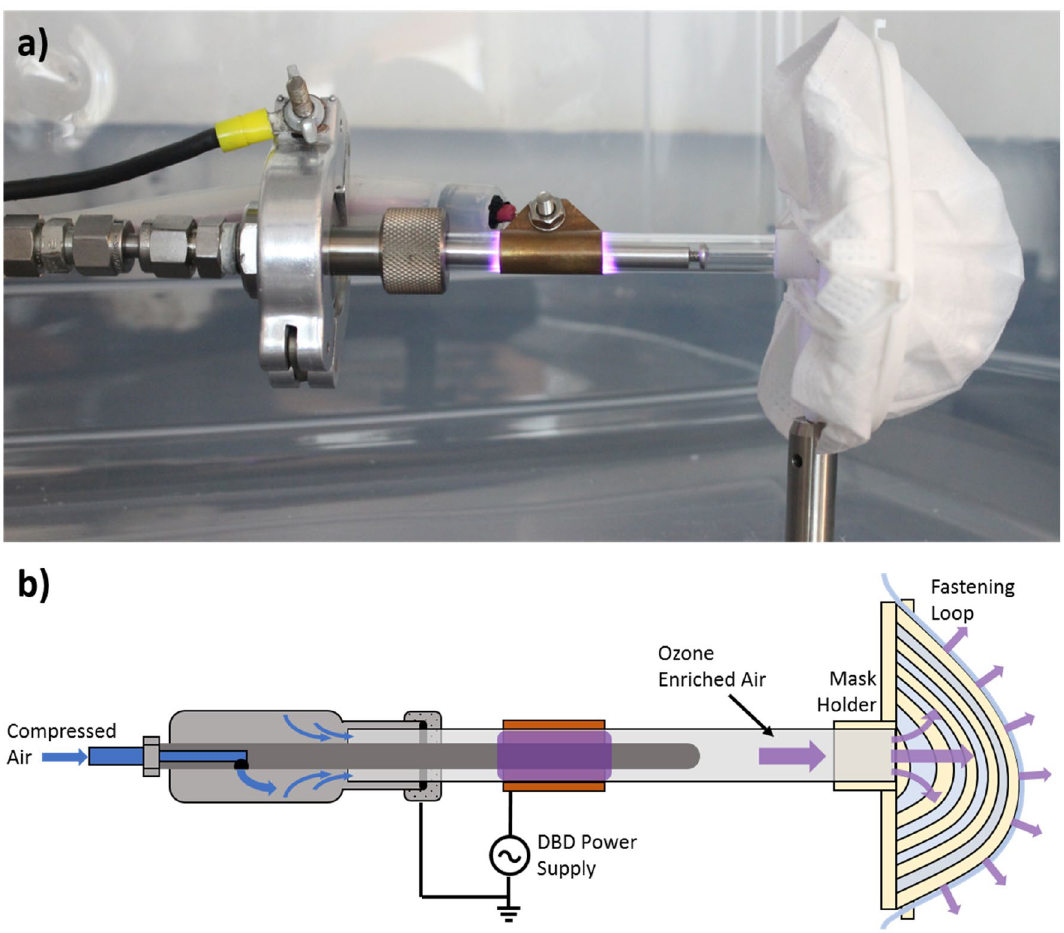
Figure 1. ( a ) Picture and ( b ) schematic of the DBD reactor used in the mask sterilizaton